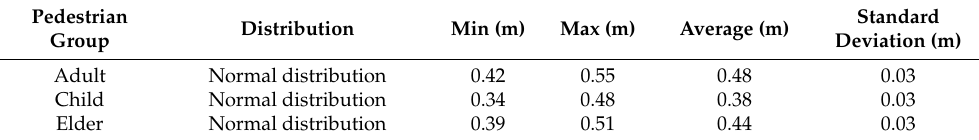
Table 2. The shoulder width parameters of the simulated pedestrian.